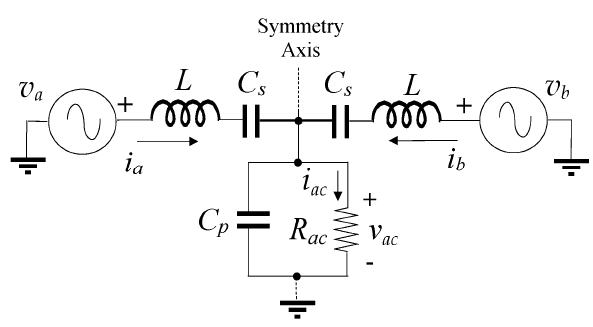
Figure 2. Simplified circuit for steady-state analysis purposes.